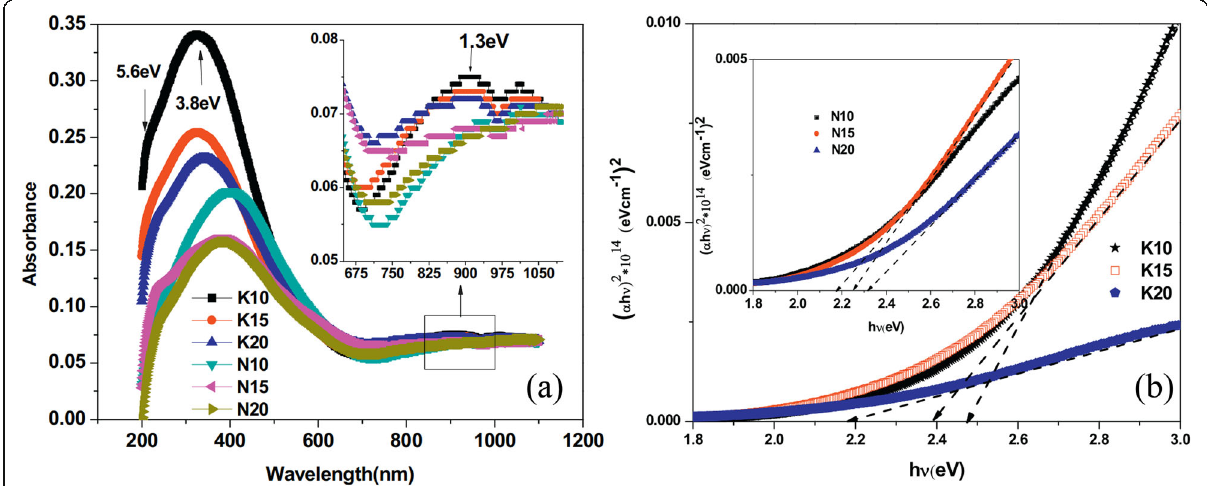
Fig. 32 a UV – Vis absorption response of the La 0.7 Ca 0.3 MnO 3 (LCMO) nanorods synthesized by hydrothermal method under different alkalinity conditions. b The variation of ( α hv ) 2 absorption versus hv (photon energy) for the different samples (N10, N15, N20, K10, K15, and K20). N (or K) means the NaOH (or KOH) mineralizer, 10 (or 15, 20) for the NaOH (or KOH) concentration. Reproduced with permission of